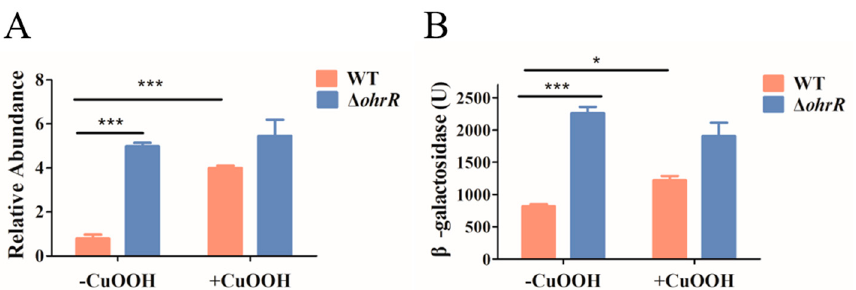
Figure 3. Induction of the expression of ohr and ohrR by organic peroxides. ( A ) Transcription of the ohr gene. qRT-PCR analysis of RNA extracted from mid-log growing cells that were untreated and treated with 0.1 mM CuOOH. The expression of ohr was normalized with 16S rRNA. ( B ) Translational fusion assay. ohr-lacZ gene expression was analyzed by measuring β -galactosidase levels. Overnight cultures of WT and Δ ohrR strains containing ohr-lacZ plasmids were incubated to early-log phase. When indicated, 0.1 mM CuOOH was added and all of the cultures were incubated for 2 h. The ohr gene expression was analyzed by measuring β -galactosidase activities. Data are mean and SD of three independent experiments. * : Student t -test P < 0.05; *** : P < 0.005.